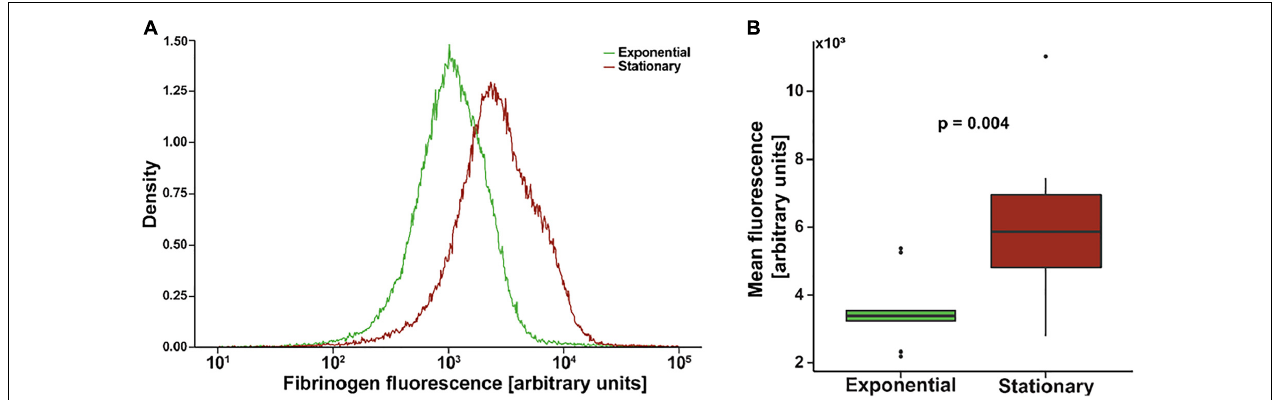
FIGURE 1 | Flow cytometry of Staphylococcus epidermidis incubated with fluorescently labeled fibrinogen. (A) Example density plot of fibrinogen fluorescence for a single flow cytometry experiment. (B) Standard box (IQR) and whiskers (1.5*IQR) plot of mean fluorescence of S. epidermidis in exponential versus stationary phase. Bacterial cell concentration was 4 × 10 9 cells/mL and fibrinogen concentration was 0.5 mg/mL. N = 9 paired experiments with triplicate